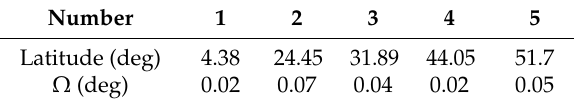
Table 6. Estimation FR of GF-3 PolSAR